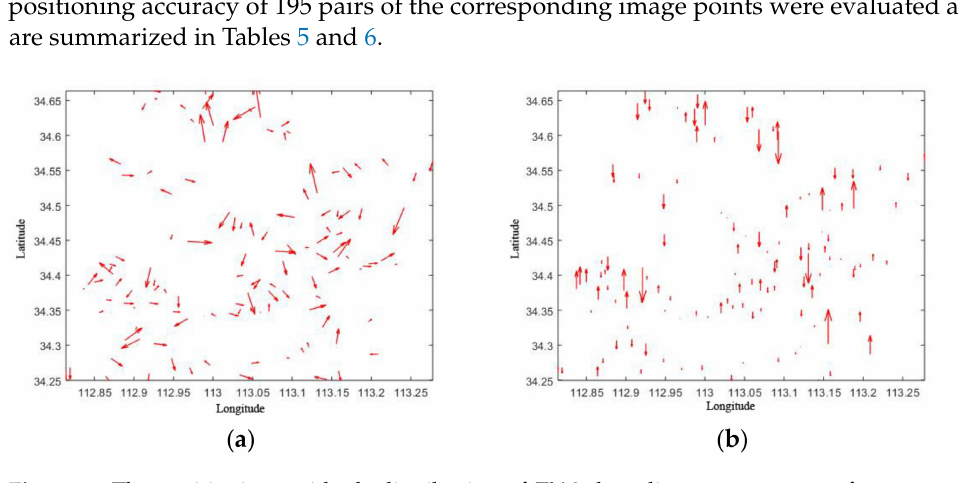
Figure 8. The positioning residuals distribution of ZY-3 three-line array camera after geometric calibration. ( a ) Positioning residuals in XY planar direction; ( b ) Positioning residuals in the elevation